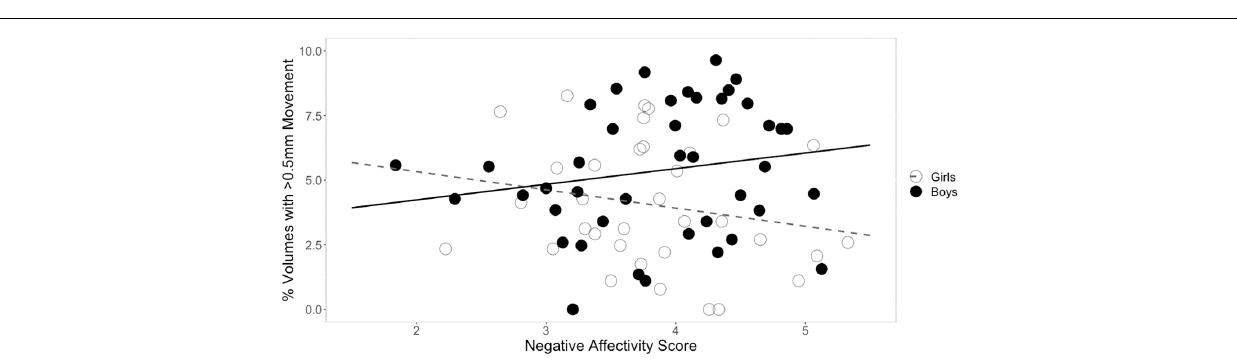
FIGURE 2 | Sex differences in the relationship between negative affectivity and movement. The square root of percent of volumes with greater than 0.5 mm of movement are plotted on the y -axis. While there was a significant interaction between negative affectivity and sex, follow-up sex specific regressions models showed that the relationship between negative affectivity scores and head movement were not significant in either